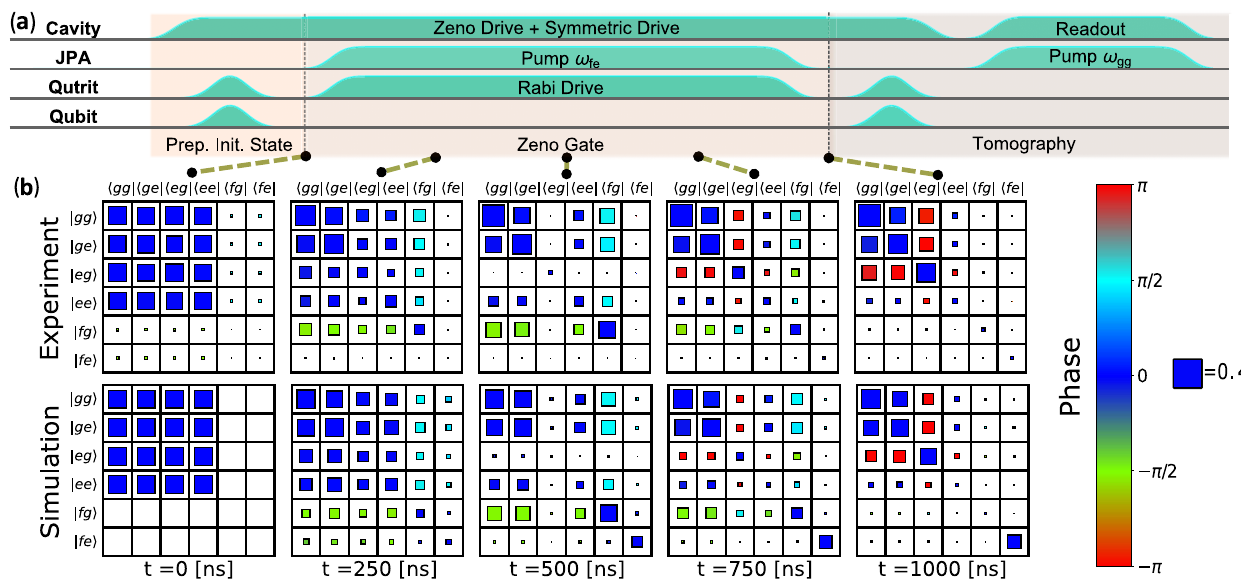
Fig. 3 Zeno gate time evolution. a Pulse sequence for the Zeno dynamics. b The qutrit-qubit density matrix at different times with ε /2 π = 2 MHz, starting with an initial þþj i state, where þj i ¼ g j i þ e j ið Þ = square stands for an amplitude of 0.4, and the color of the fi lling represents the phase according to the color bar. Experimental results (top row), numerical simulation (bottom row).